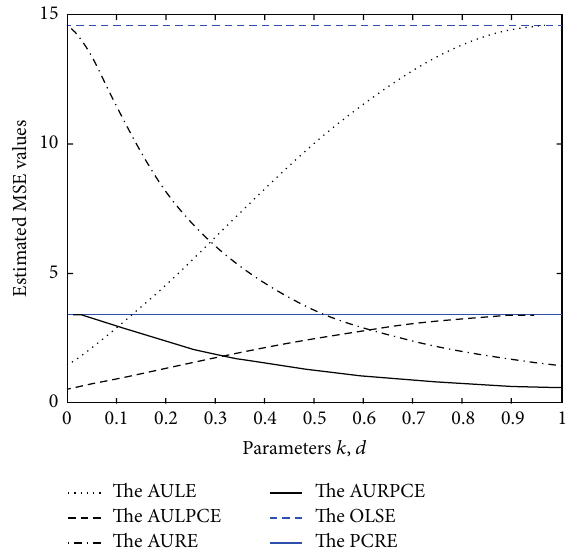
Figure 1: Estimated MSE values of the AULE, AULPCE, AURE, AURPCE, OLSE, and